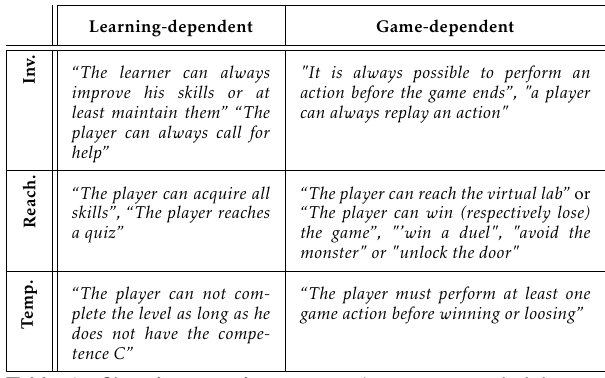
Table 1. Classification of properties (invariant, reachability and